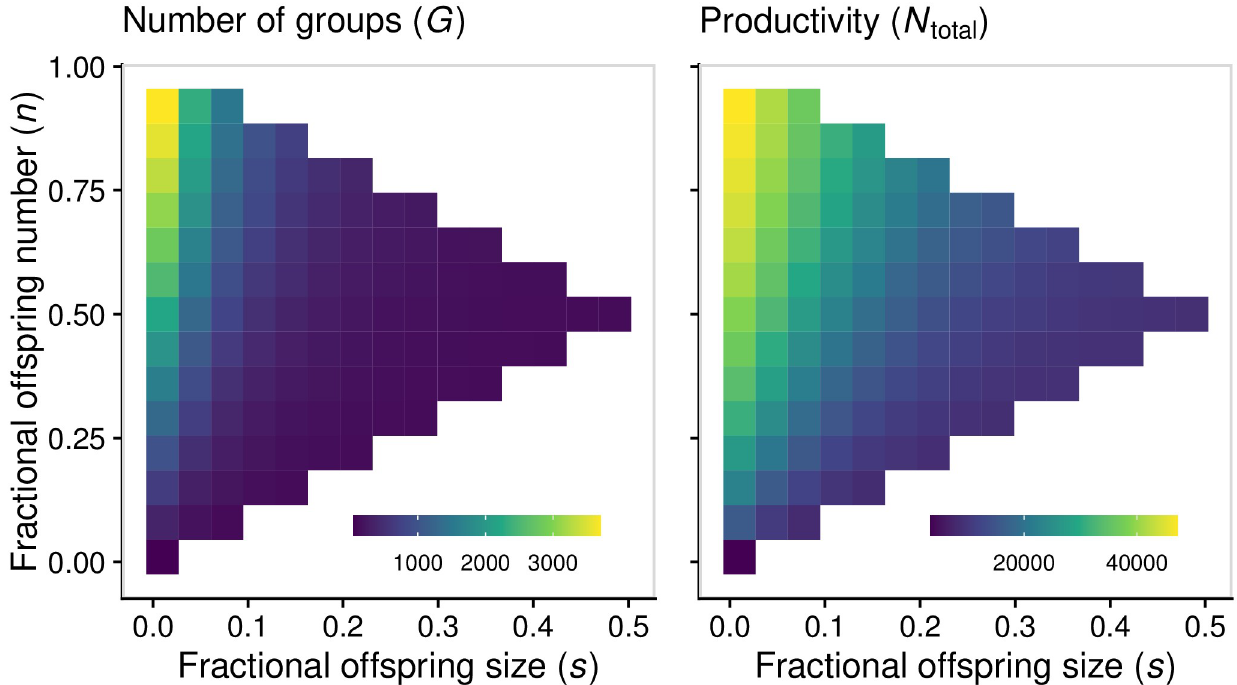
Fig 2. In the absence of mutations, with a single species, complete fragmentation into single cells maximizes equilibrium population size, measured either as total number of groups ( G ) or as total productivity ( N total ). Parameters: μ = 0; all other parameters set to the default values (Table A in S1 Text).